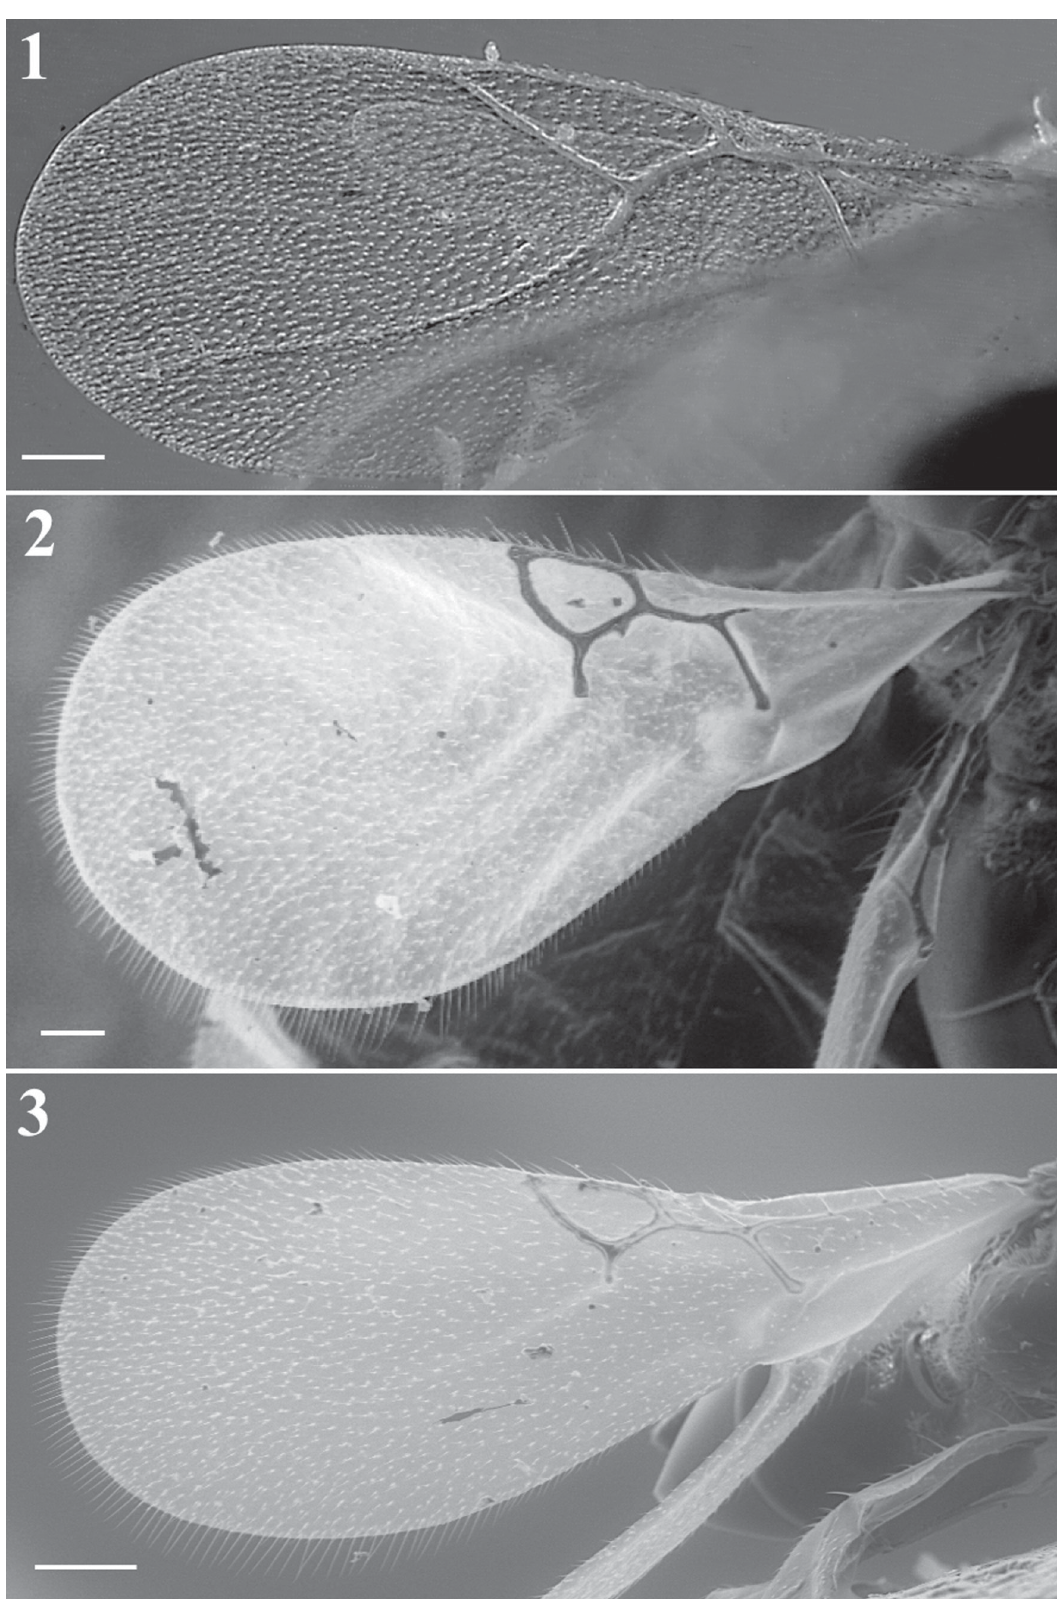
Fig. 10. Types of fore wing. 1 . Phaenoglyphis evenhuisi Pujade-Villar & Paretas-Martínez, 2006. 2 . Alloxysta brevis (Thomson, 1862). 3 . A. darci (Girault, 1933). Scale bars: 50